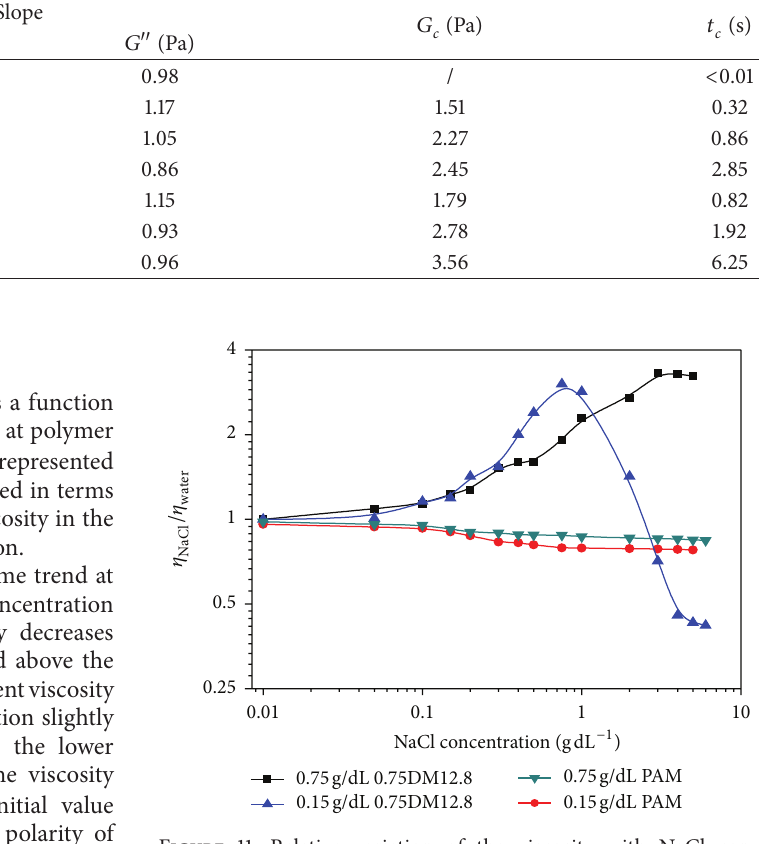
Figure 11: Relative variation of the viscosity with NaCl con- centration for copolymer 0.75DM12.8 and PAM at two different concentrations (shear rate 7.34s −1 , 𝑇 = 25 ∘